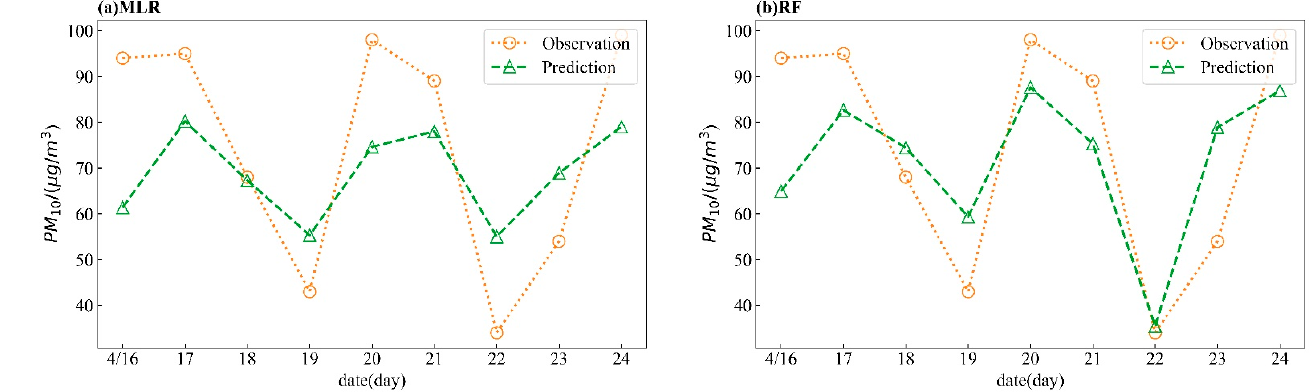
Figure 12. Comparison between predicted and observed daily mean values of PM 10 concentration in Xining City from 16 to 24 April, 2022 ( a ): Multiple Linear Regression, ( b ): Random Forecast.